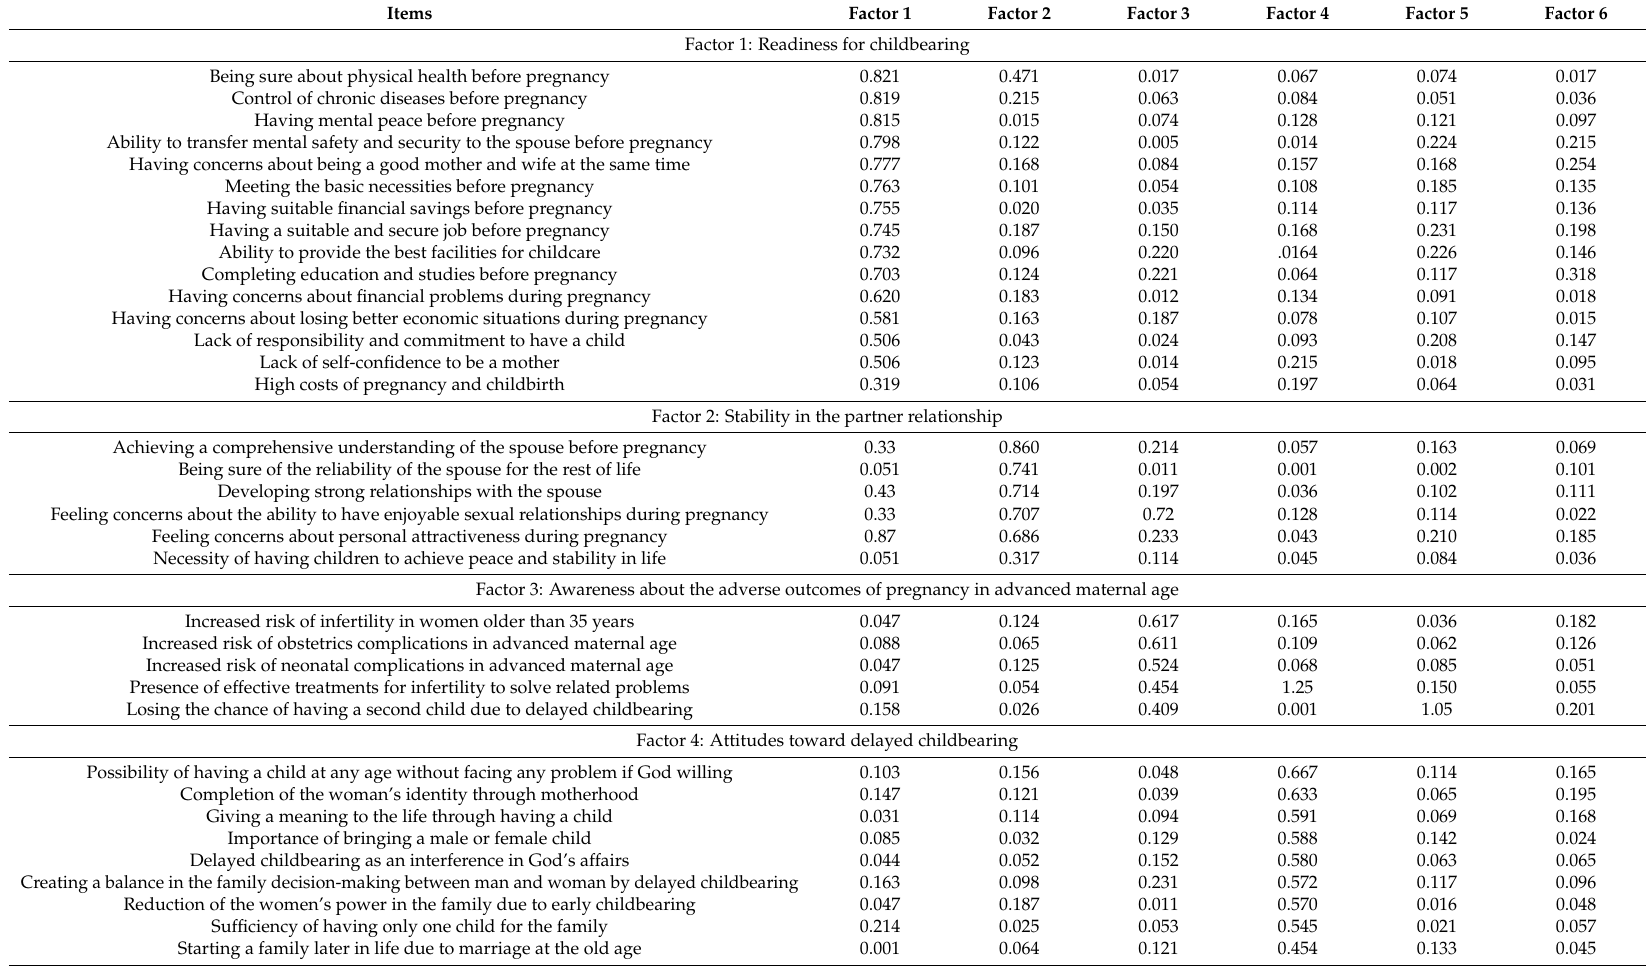
Table 2. Factors, items and factor loadings of The Delayed Childbearing Questionnaire (DCBQ-55)* ( n =